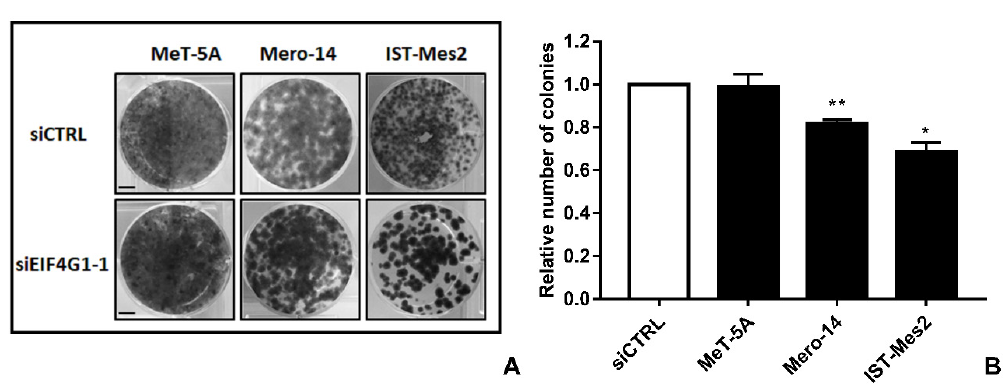
Figure 3. EIF4G1 silencing and colony formation ability. ( A ) : Colonies in MeT-5A and MPM cell lines fixed and stained 14 days after treatment with siCTRL or siEIF4G1-1. This is a representative picture of one experiment. Scale bar: 1 cm ( B ) : Histogram represents number of colonies measured 14 days after silencing with siEIF4G1-1, compared to siCTRL. Error bars are SEM of three different experiments, each performed in triplicate. Statistical significance is indicated by asterisk (*), where * p < 0.05; ** p < 0.01; compared to control treatment.